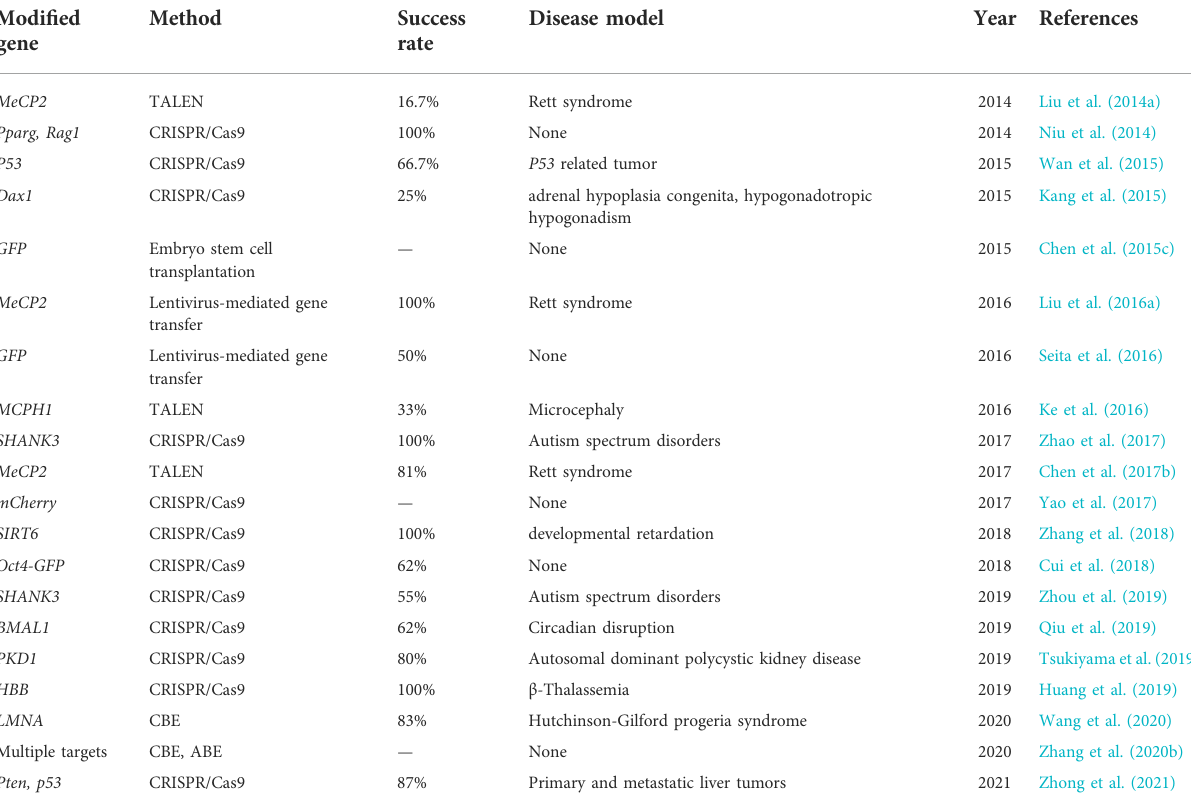
TABLE 2 Cynomolgus monkey models established by various gene editing